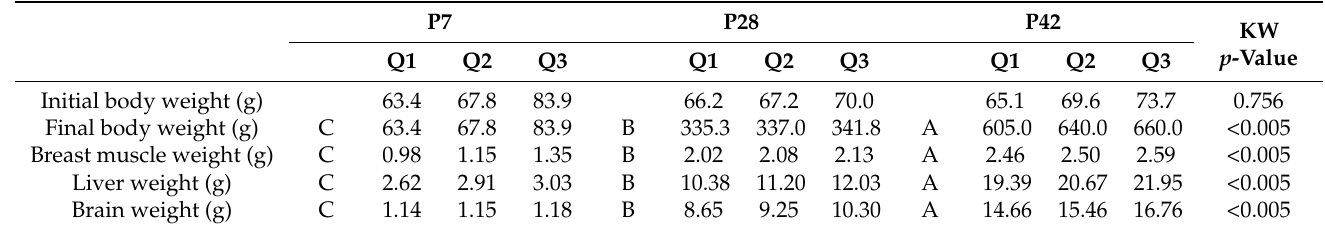
Table 1. Body and tissue weights during post-hatch developmental period in